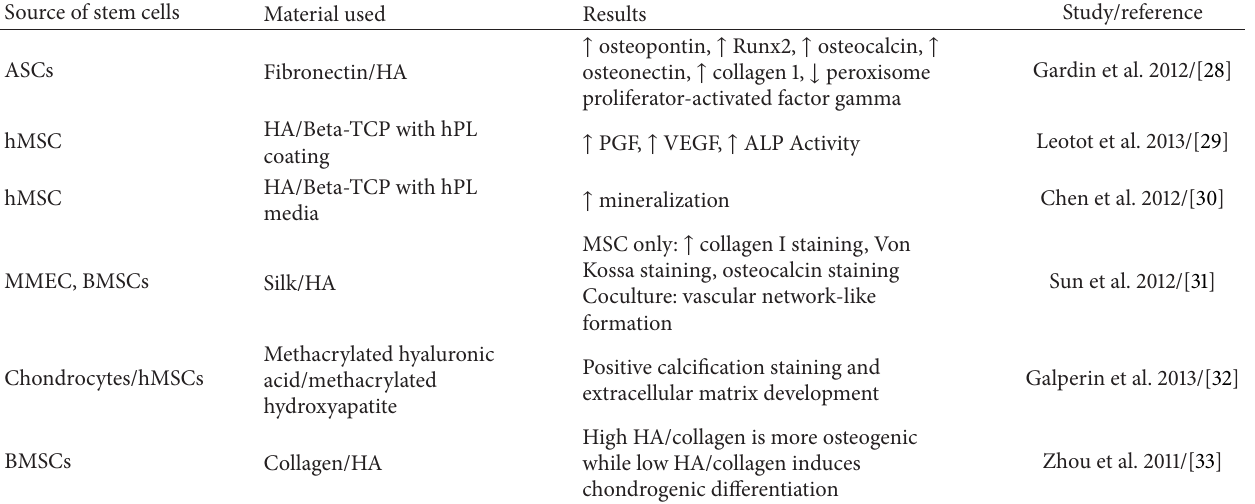
Table 3: Summary of references for dual